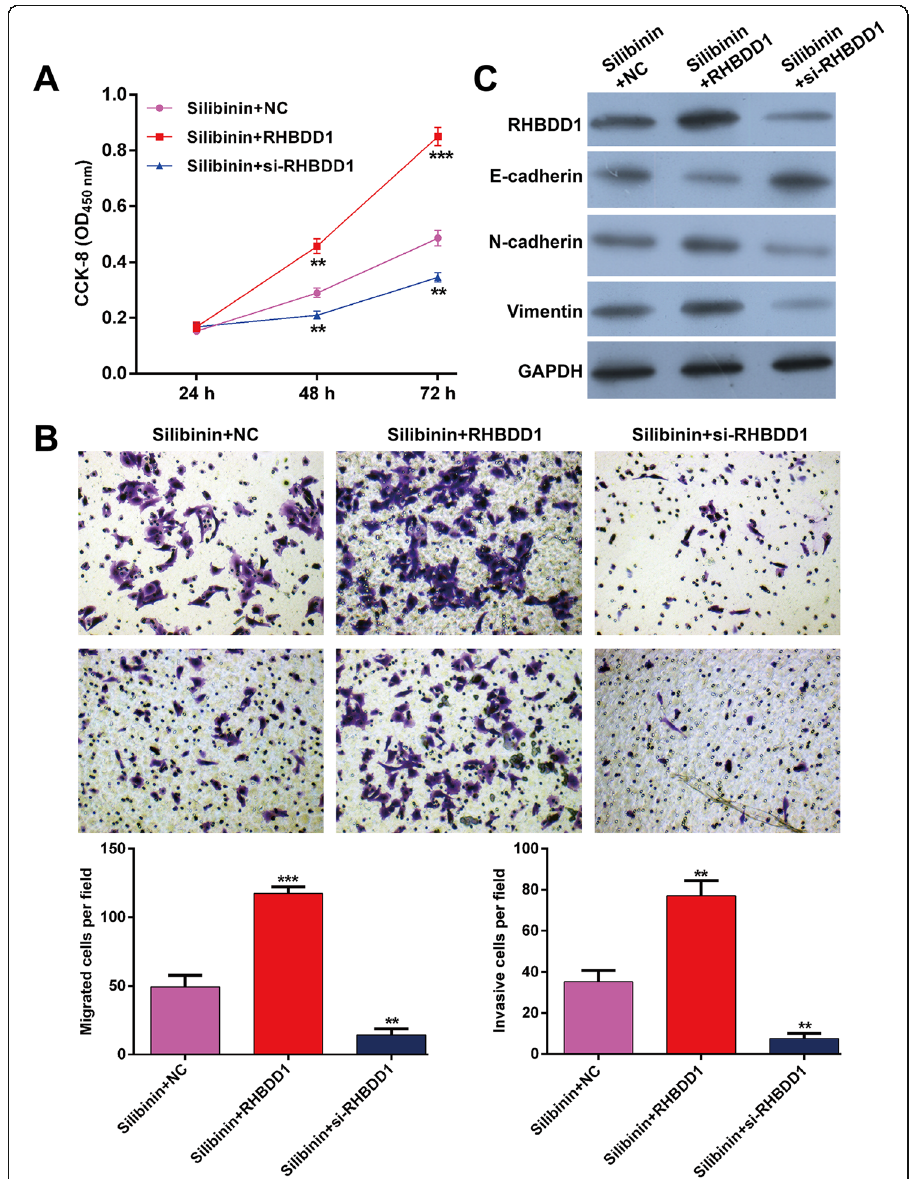
Fig. 5 Silibinin affects NSCLC cell proliferation, migration and invasion by regulating RHBDD1. RHBDD1 overexpression plasmid, si-RHBDD1 and the relevant negative control (NC) were transfected into A549 cells, followed by treatment with 40 μ M silibinin. a Cell proliferation was analyzed using the CCK-8 assay. b Transwell migration and invasion assays were performed in A549 cells. c The protein expressions of RHBDD1, E-cadherin, N-cadherin and vimentin were determined using western blotting. Data are expressed as means ± standard deviation (SD). ** p < 0.01, *** p < 0.001, compared with silibinin +